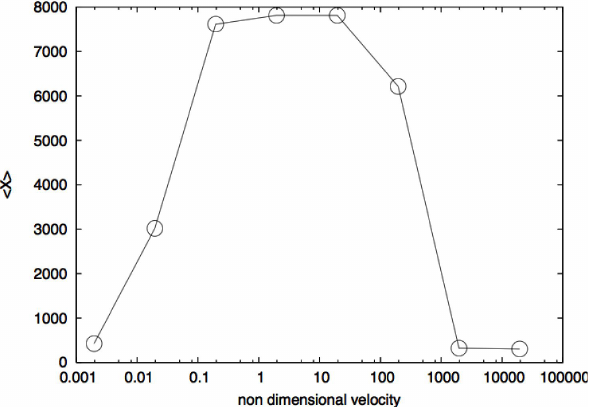
Fig. 14. The quantity h D x i as a function of v